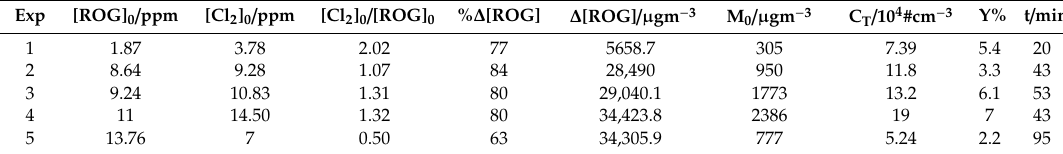
Table 3. Aerosol yield (Y) for di ff erent ratios of furfural (ROG) / Cl 2